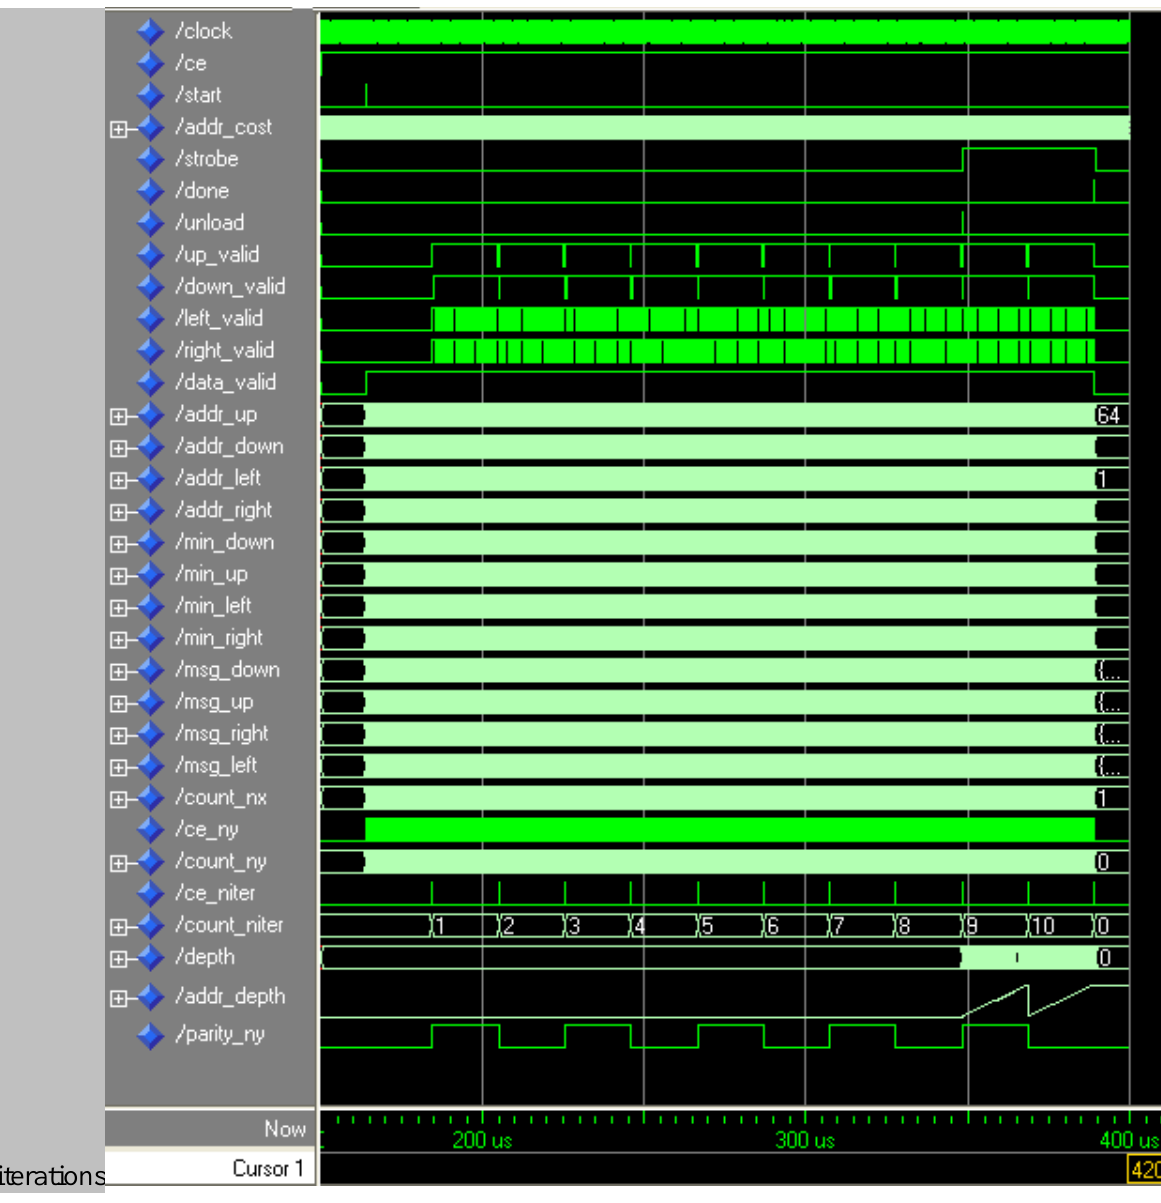
Figure 8. Functional simulation of belief propagation for a 64 × 64 frame and